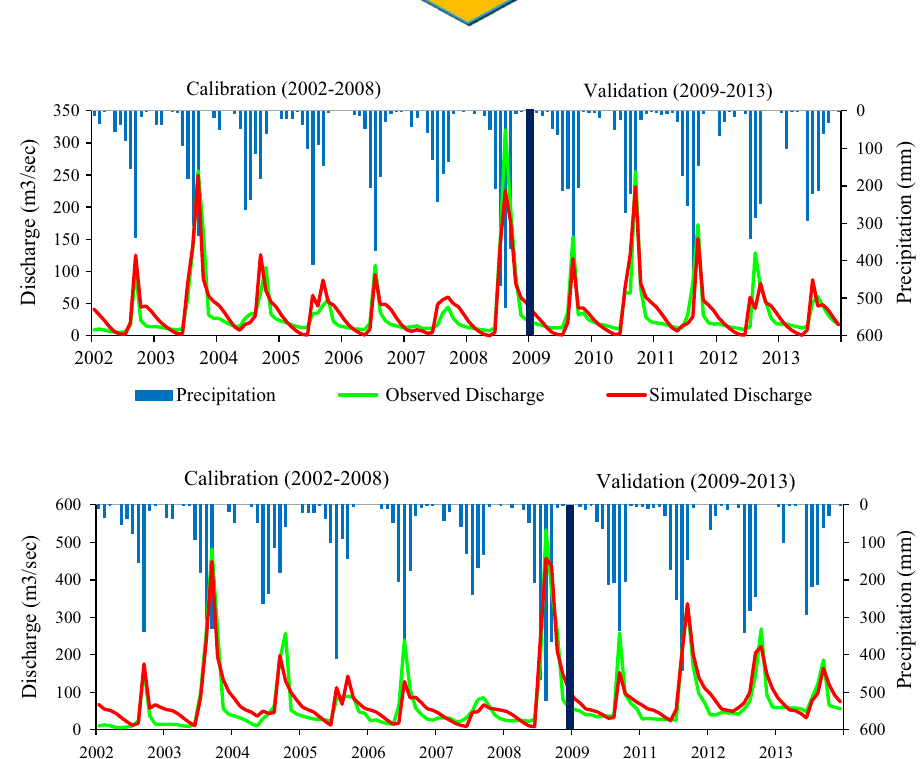
Fig. 9 Observed and simulated monthly flows at